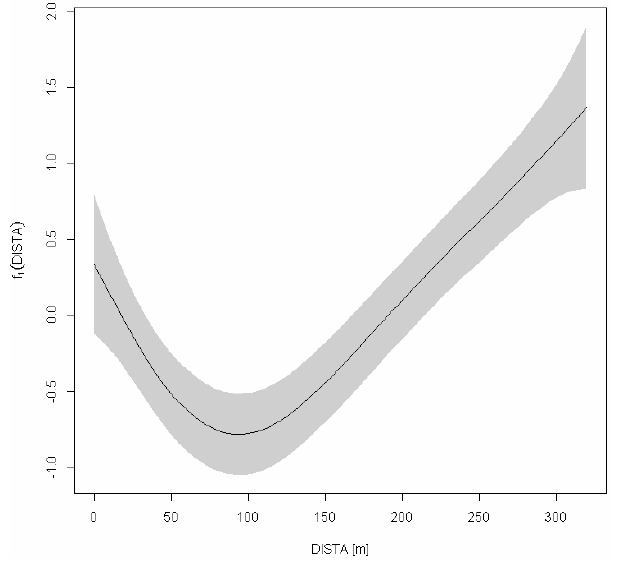
Figure 2 1095 Fig. 2. Nonlinear effect of a vegetation square’s distance from grid- row A (DISTA) on the portion of rill cells (RILLR) (see Eq. 8). Shaded: 95%-confidence area.